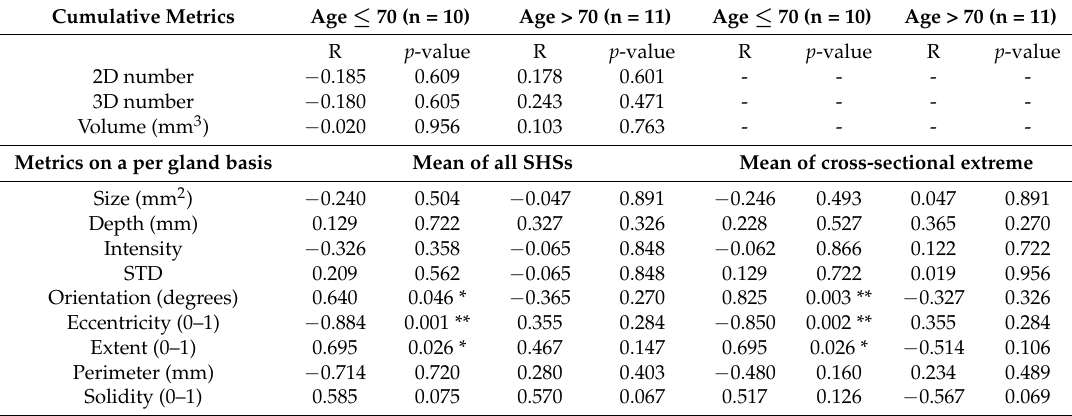
Table 4. Correlation between pre-ablation squamous SHS metrics and the relative change of maximum BE length after RFA in different age